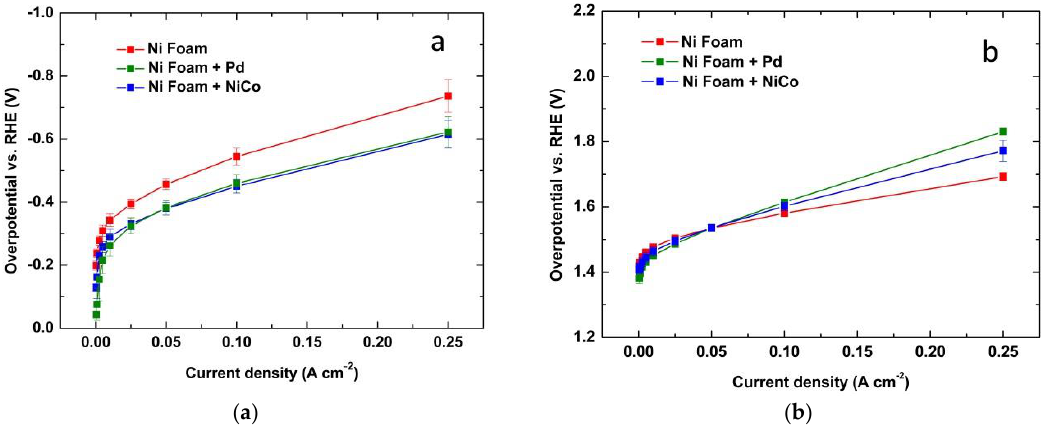
Figure 10. Galvanostatic step tests for ( a ) HER and ( b ) OER carried out in 30% w/w KOH aqueous solution for Ni foam-based